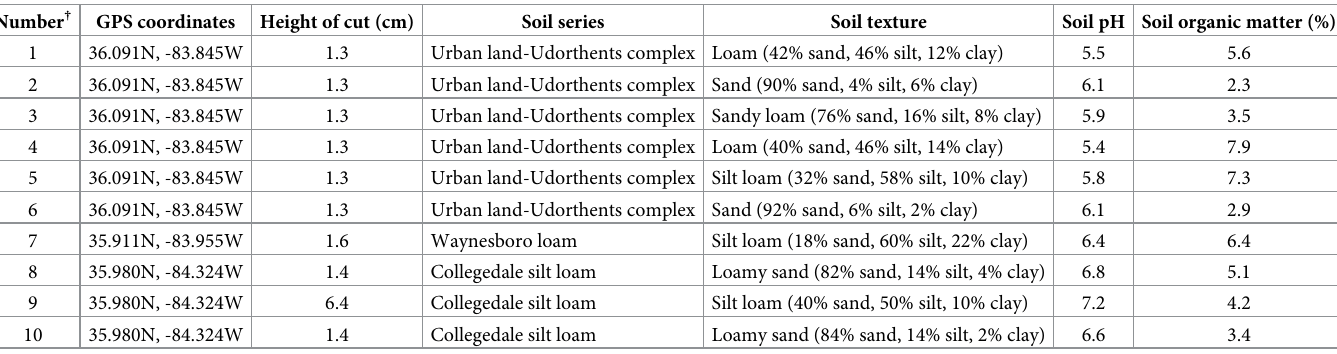
Table 1. Site characteristics for micro-environments monitored from 11 May to 27 October of 2020 to assess Poa annua survival. Number † GPS coordinates Height of cut (cm) Soil